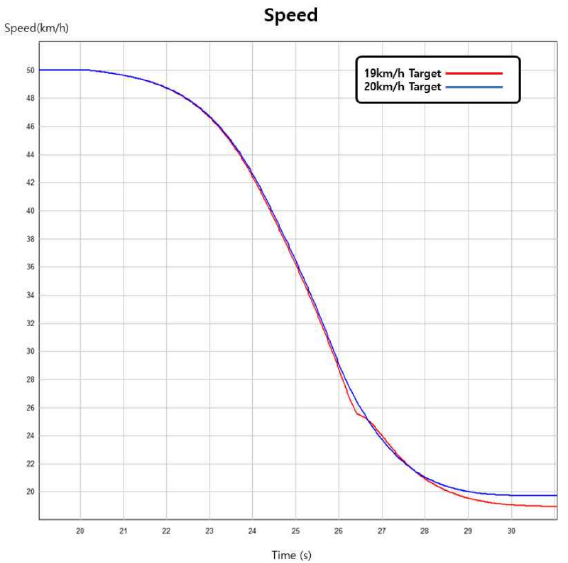
Figure 26. Maximum braking comparison when setting target speed as 19 km/h and 20